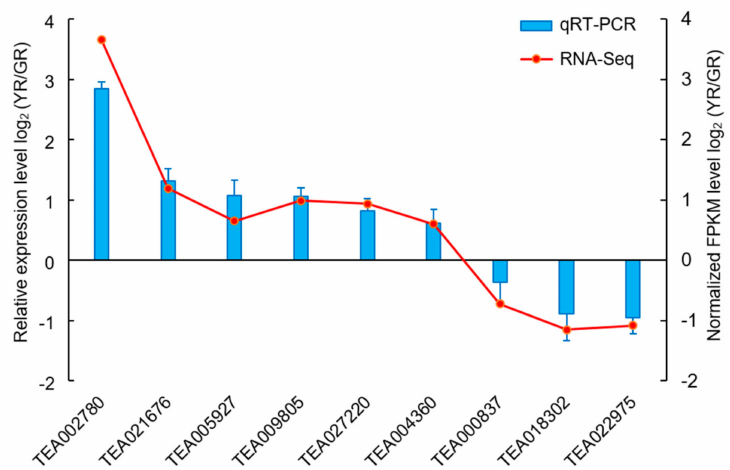
Figure 5. Validation of the transcription levels for randomly selected DEGs by qRT-PCR.